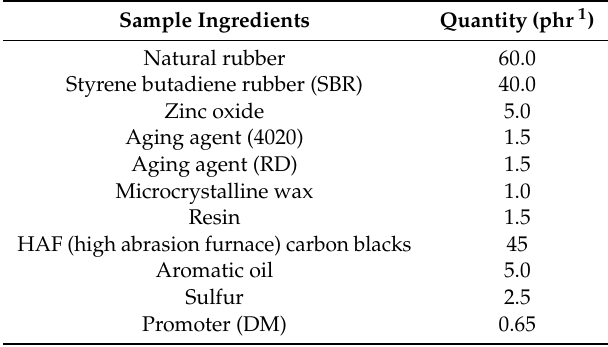
Table 1. Composition of the rubber fenders used in the present